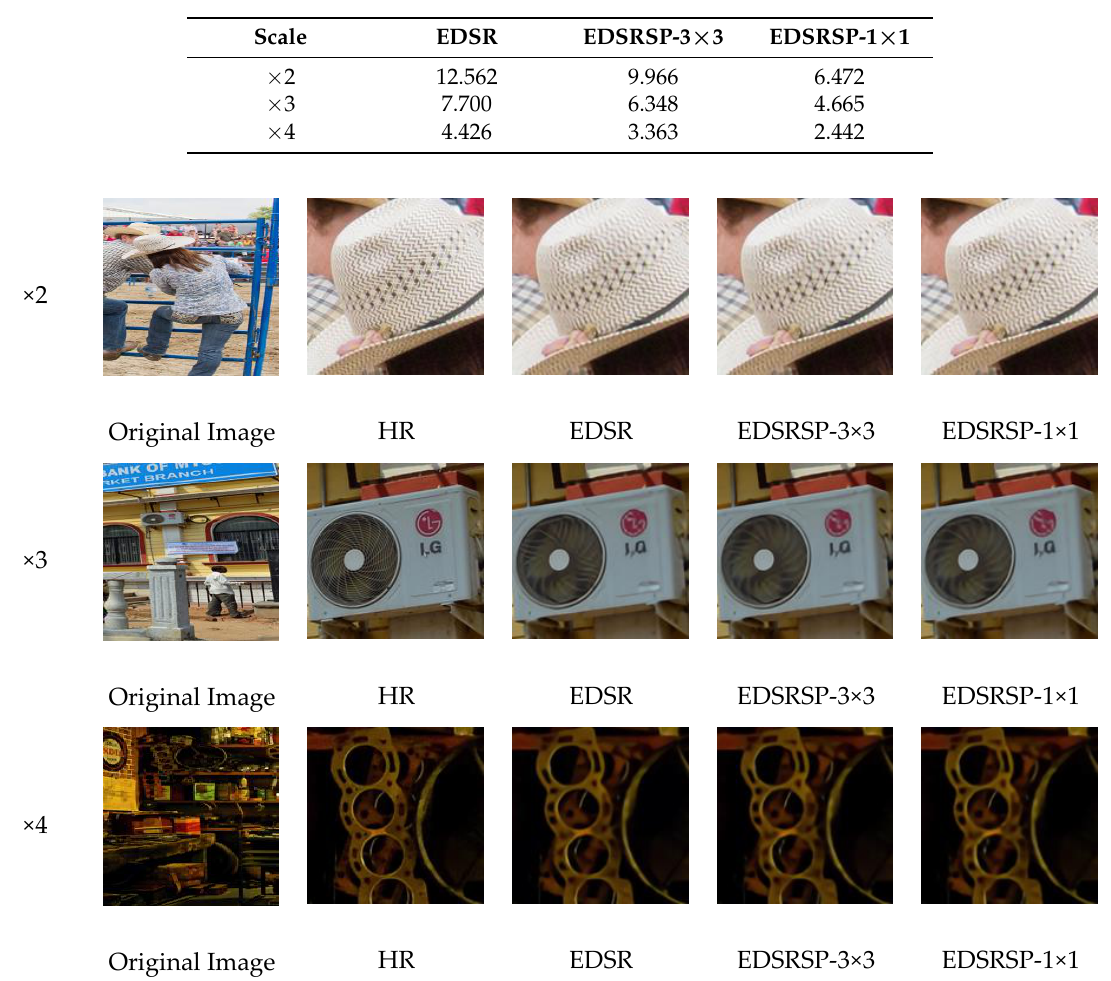
Table 3. Running time (s) comparison between EDSR and proposed models.